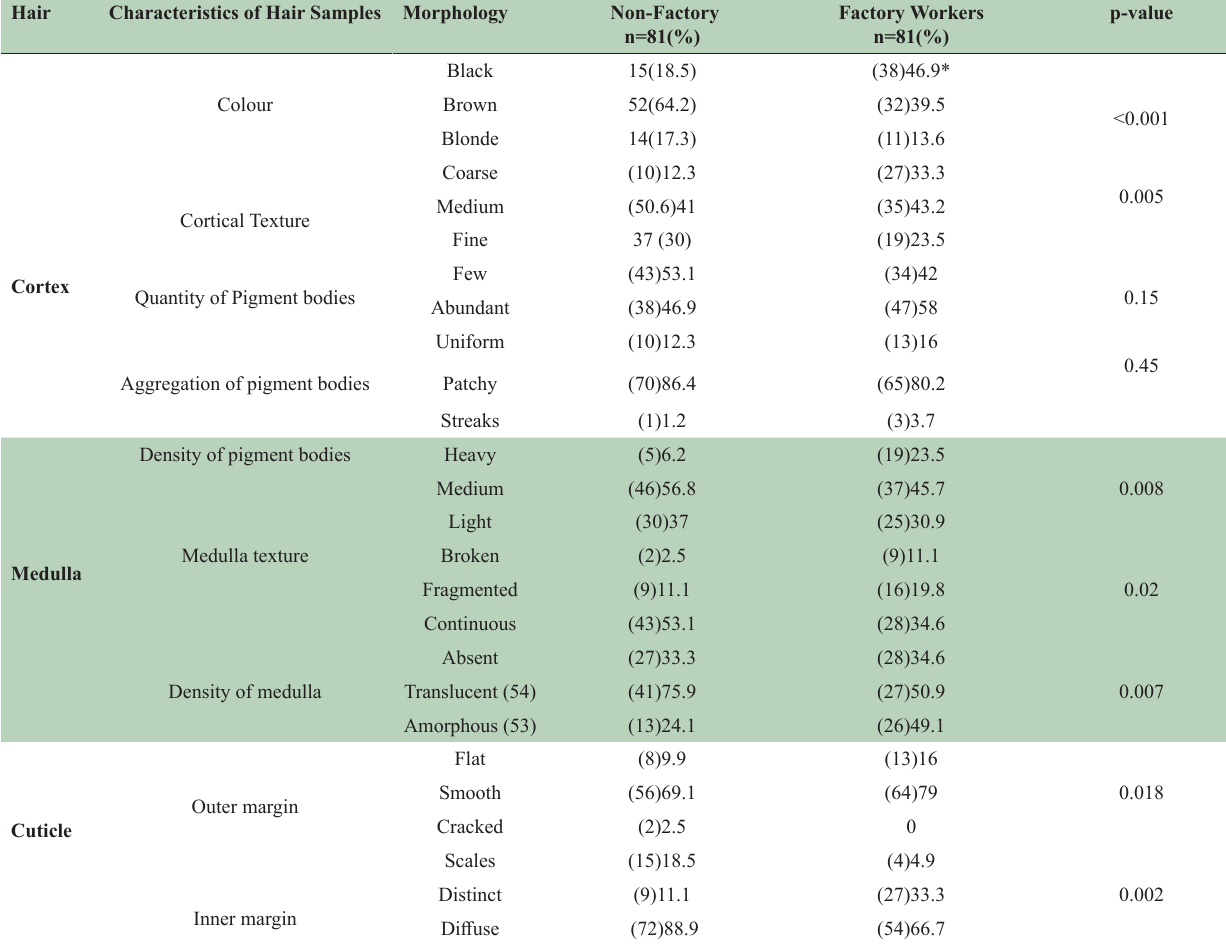
Table-III: Comparison of qualitative parameters of hair in factory and non-factory workers.